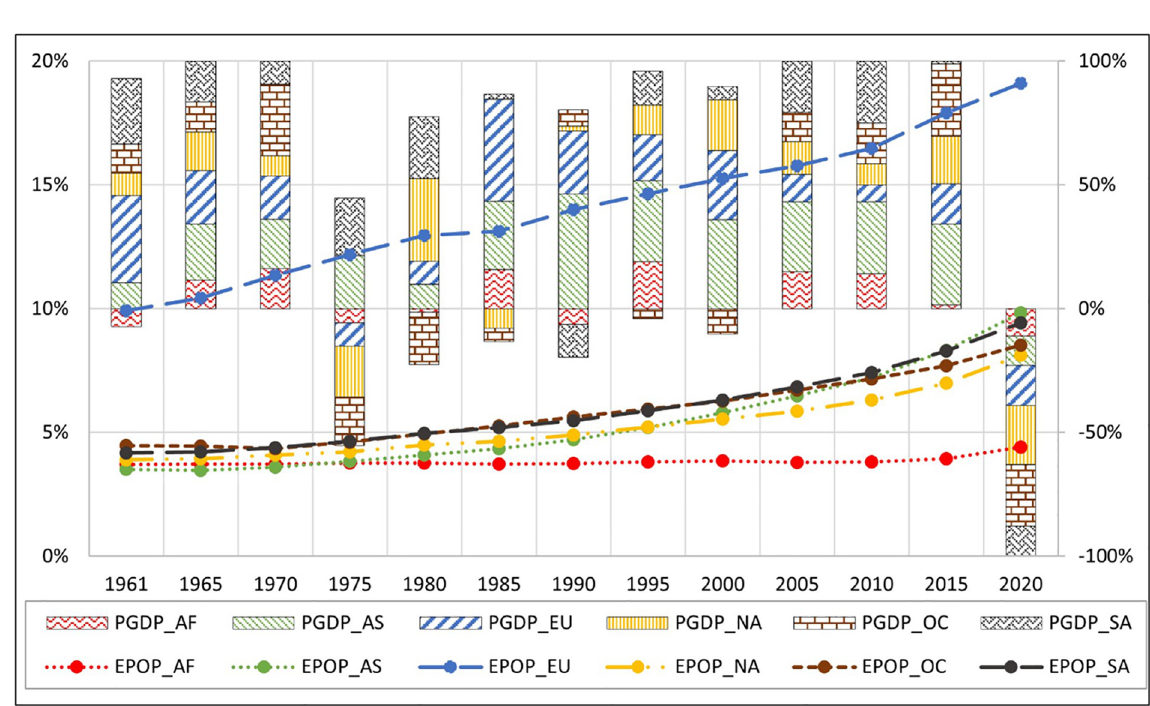
Fig 2. Combination chart on mean annual GDP per capita growth rate and mean elderly population (as a percentage of the total) over time. Source: Authors’ compilation based on World Development Indicators. https://doi.org/10.1371/journal.pone.0278716.g002 The direction of the arrows in Fig 3 indicates whether the variables move in-phase (right- ward arrow indicating a positive correlation), or anti-phase (leftward arrow indicating a nega- tive correlation). The cold (blue) regions of the Figure indicate no correlation while the warm (red) regions depict the analysed variables are correlated. In Fig 4, all countries between 1960 and 1970, in the medium-term (medium frequency), rightward arrows portray a positive correlation between economic growth and the elderly